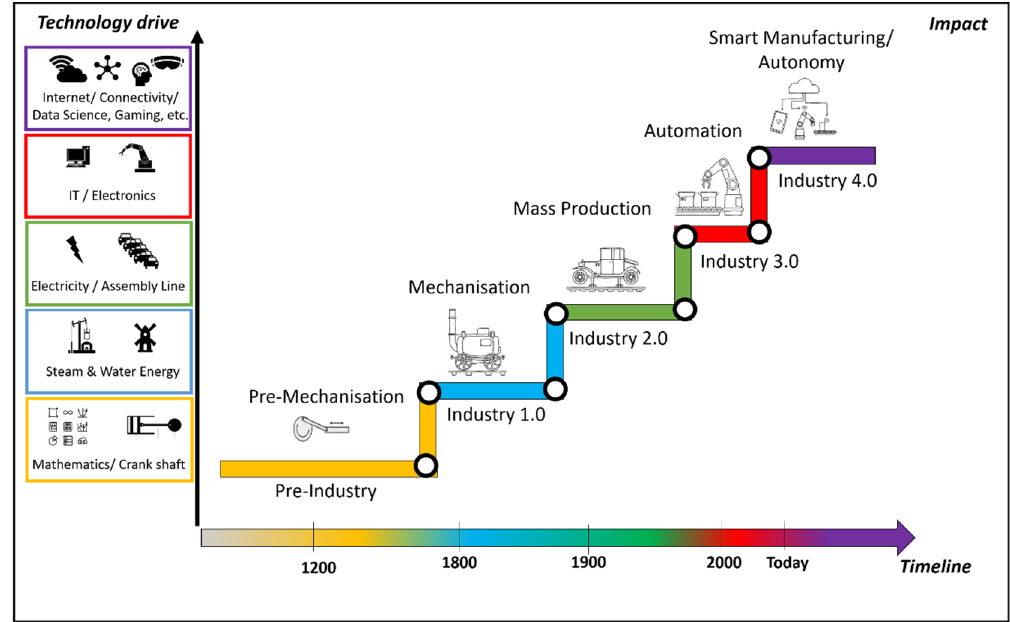
Figure 2. Three-dimensional map of industrial revolutions ( Y -axis: Technology drive, X -axis: Timeline of evolution, Z -axis: Impact to the manufacturing industry). (Author’s creation).